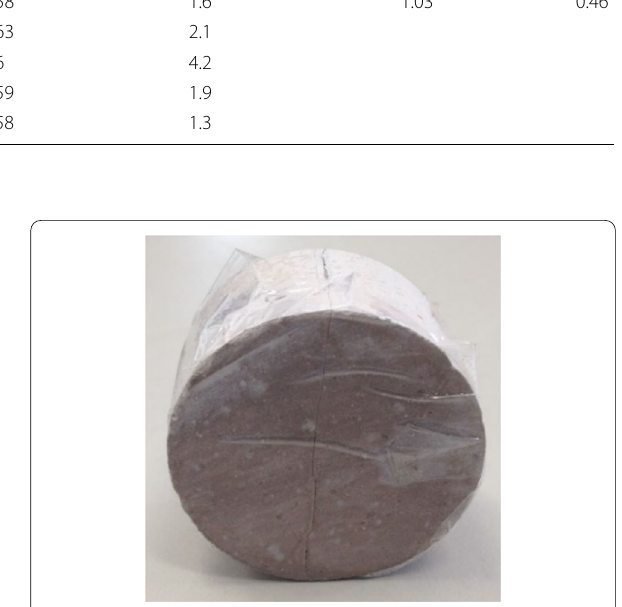
Fig. 6 Failure state in the STS